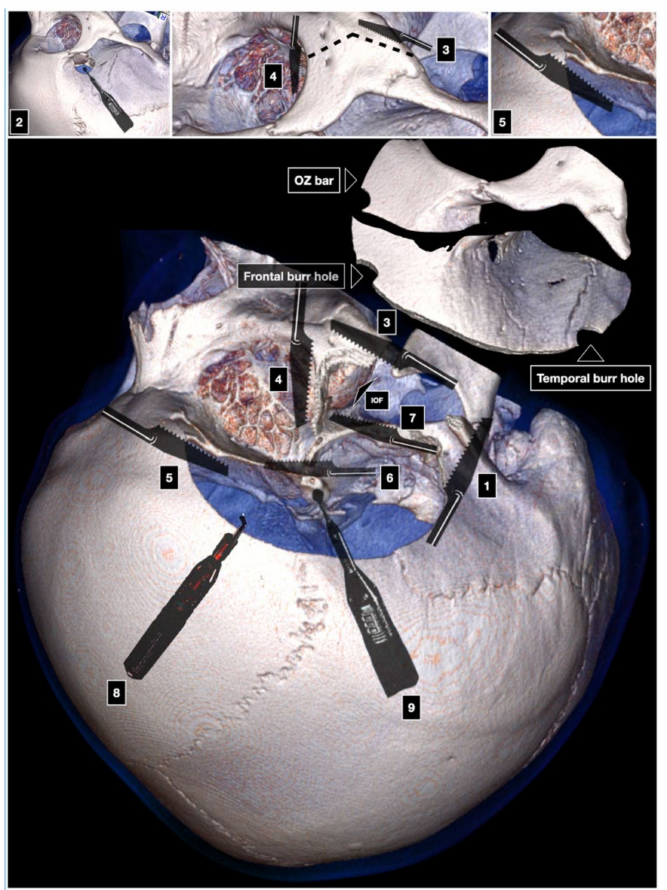
Figure 4. Zabramski technique of the two-piece COZ approach. OZ: orbitozygomatic. IOF: inferior orbital fissure. 1: first cut; 2: McCarty keyhole; 3: second cut; 4: third cut; 5: fourth cut; 6: fifth cut; 7: sixth cut; 8: removal of the OZ bar; 9: anterior